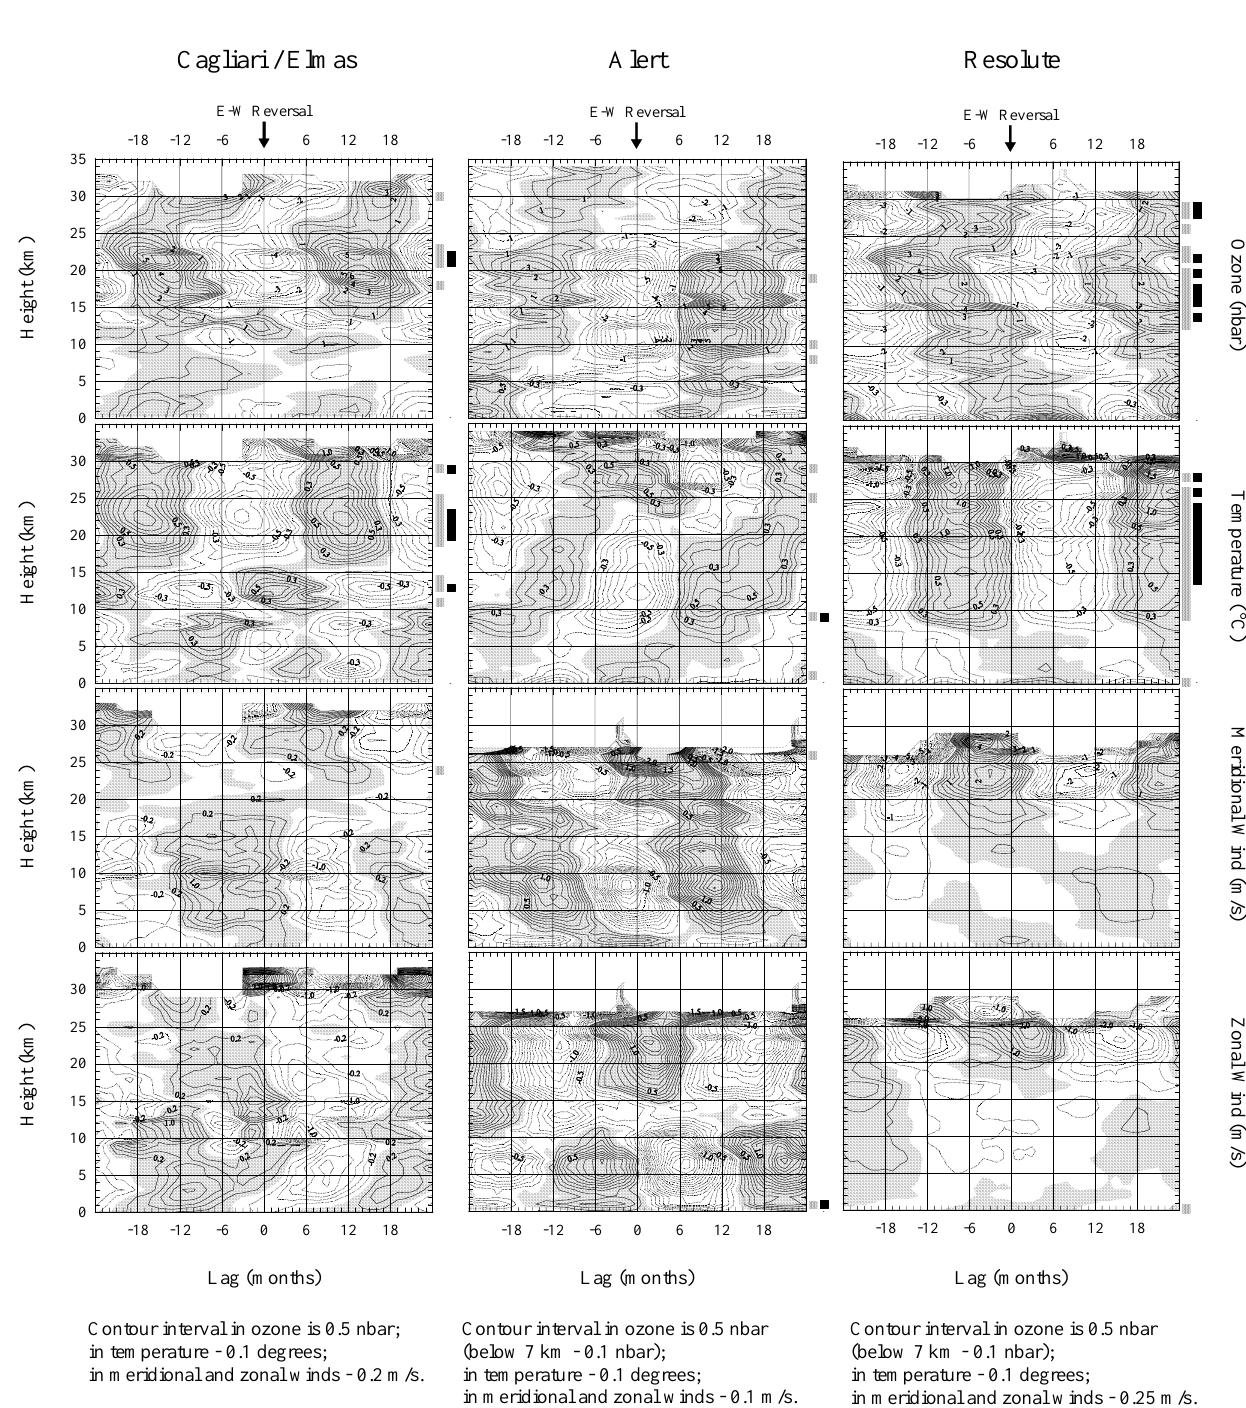
Contour interval in ozone is 0.5 nbar (below 7 km - 0.1 nbar); in temperature - 0.1 degrees; in meridional and zonal winds - 0.1